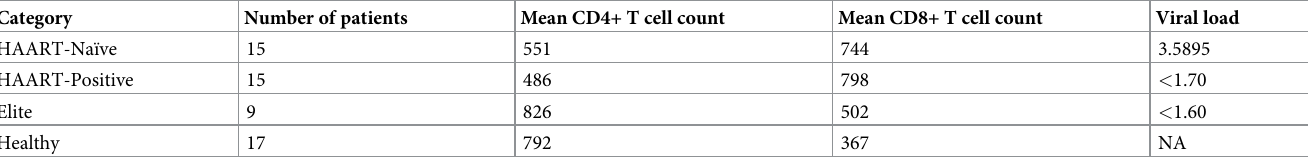
Table 1. Clinical parameters of study